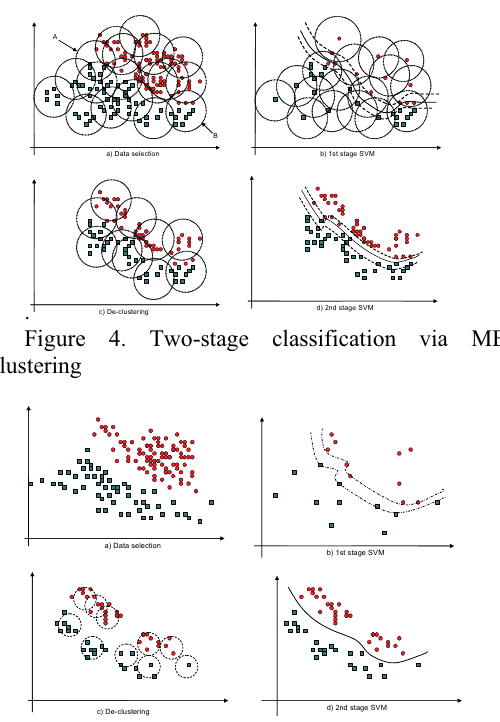
Figure 5. Two-stage classification via random